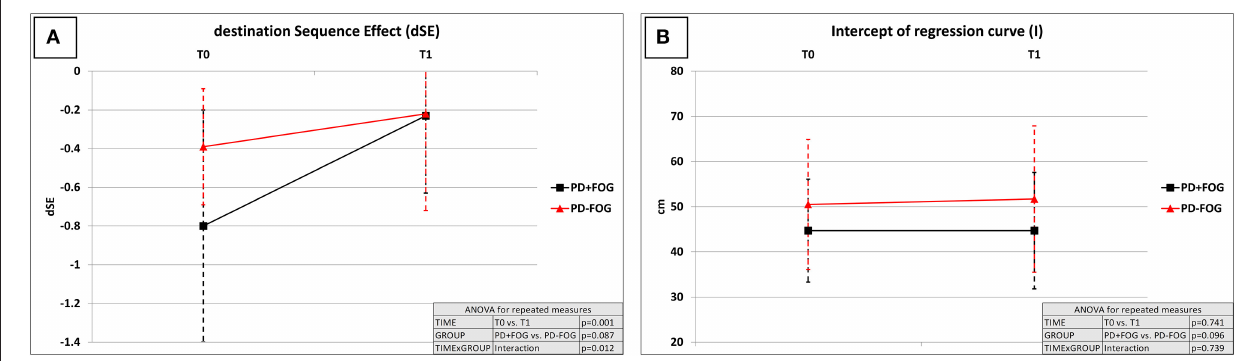
FIGURE 1 | Effect of the rehabilitation program on destination sequence effect (dSE) and hypokinesia (measured by intercept “ I ”). dSE, destination sequence effect; I , intercept of regression curve (measure of gait hypokinesia); T0, hospital admission; T1, end of the 4-week rehabilitation program—hospital discharge; PD + FOG, patients with Parkinson’s disease with freezing of gait (black lines— n = 23); PD – FOG, patients with Parkinson’s disease without freezing of gait (red lines— n = 20). Two-way repeated measures ANOVA with within-group TIME (T0 vs. T1) and between-groups GROUP (PD + FOG vs. PD – FOG) factors. (A) dSE: TIME: p = 0.001; GROUP: p = 0.087; TIME × GROUP: p = 0.012. The dSE improved at the end of the rehabilitation period in the overall study population, with a more pronounced improvement in the PD + FOG group when compared to the PD–FOG group. At T1, the dSE was comparable between the PD + FOG and PD – FOG groups ( p